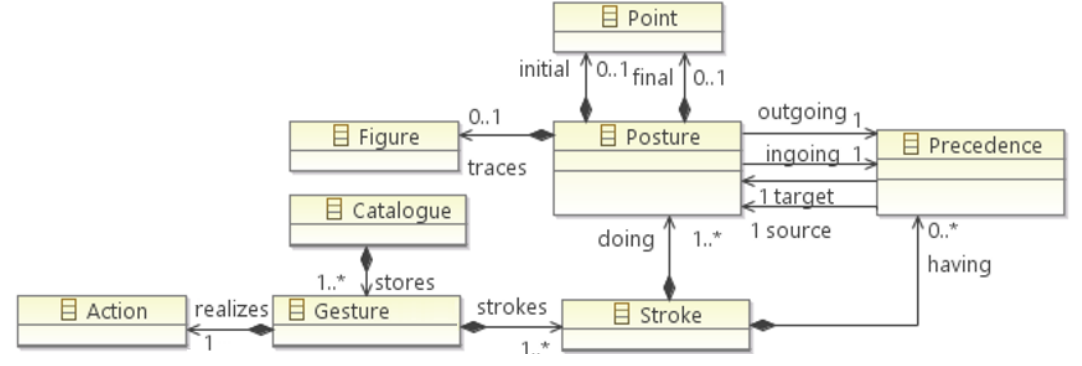
Figure 3. Metamodel of the gesture catalogue modelling